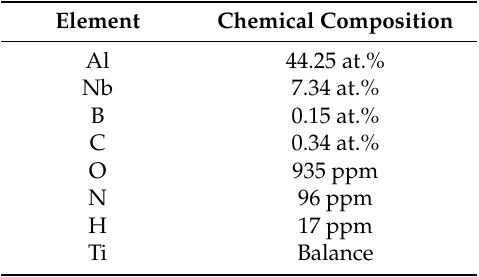
Table 1. Chemical composition of researched